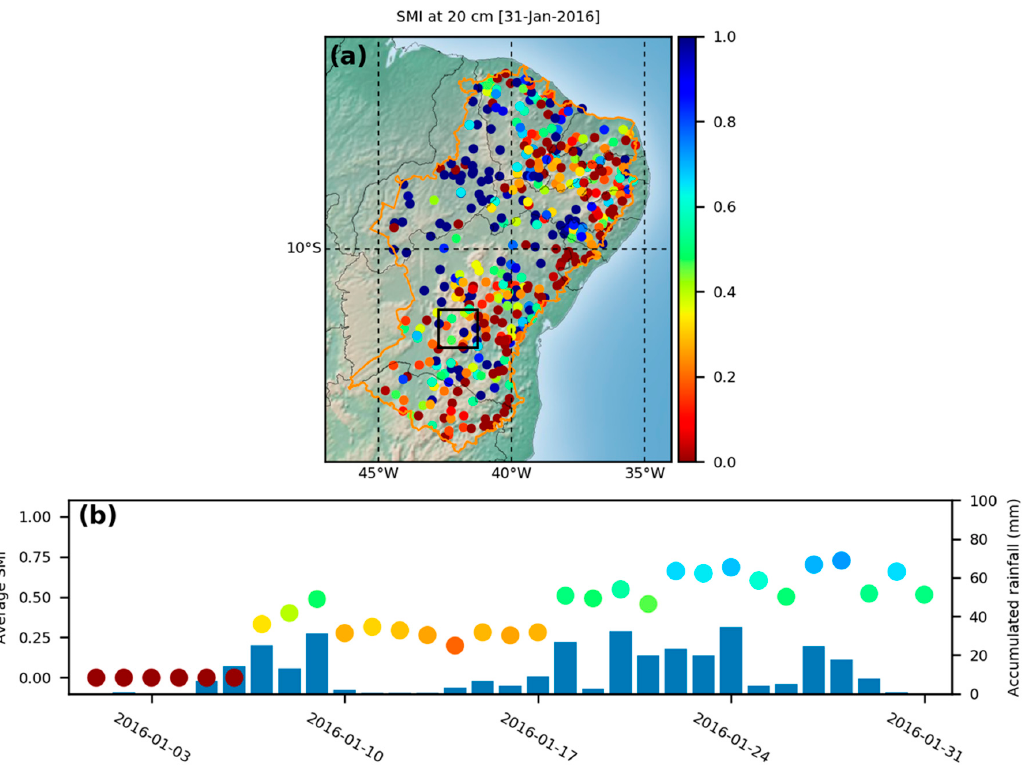
Figure 7. ( a ) SMI for 31 January 2016; and ( b ) left axis : average SMI over the stations inside the square during the last 30 days; and right axis : daily accumulated rainfall.